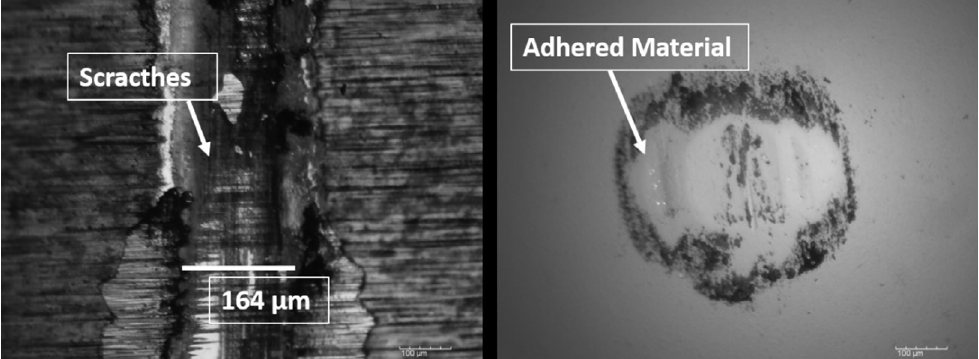
Figure 7. Worn track for the Ni-P 400-1 condition: a) wear pattern; b) counter-face aspect.